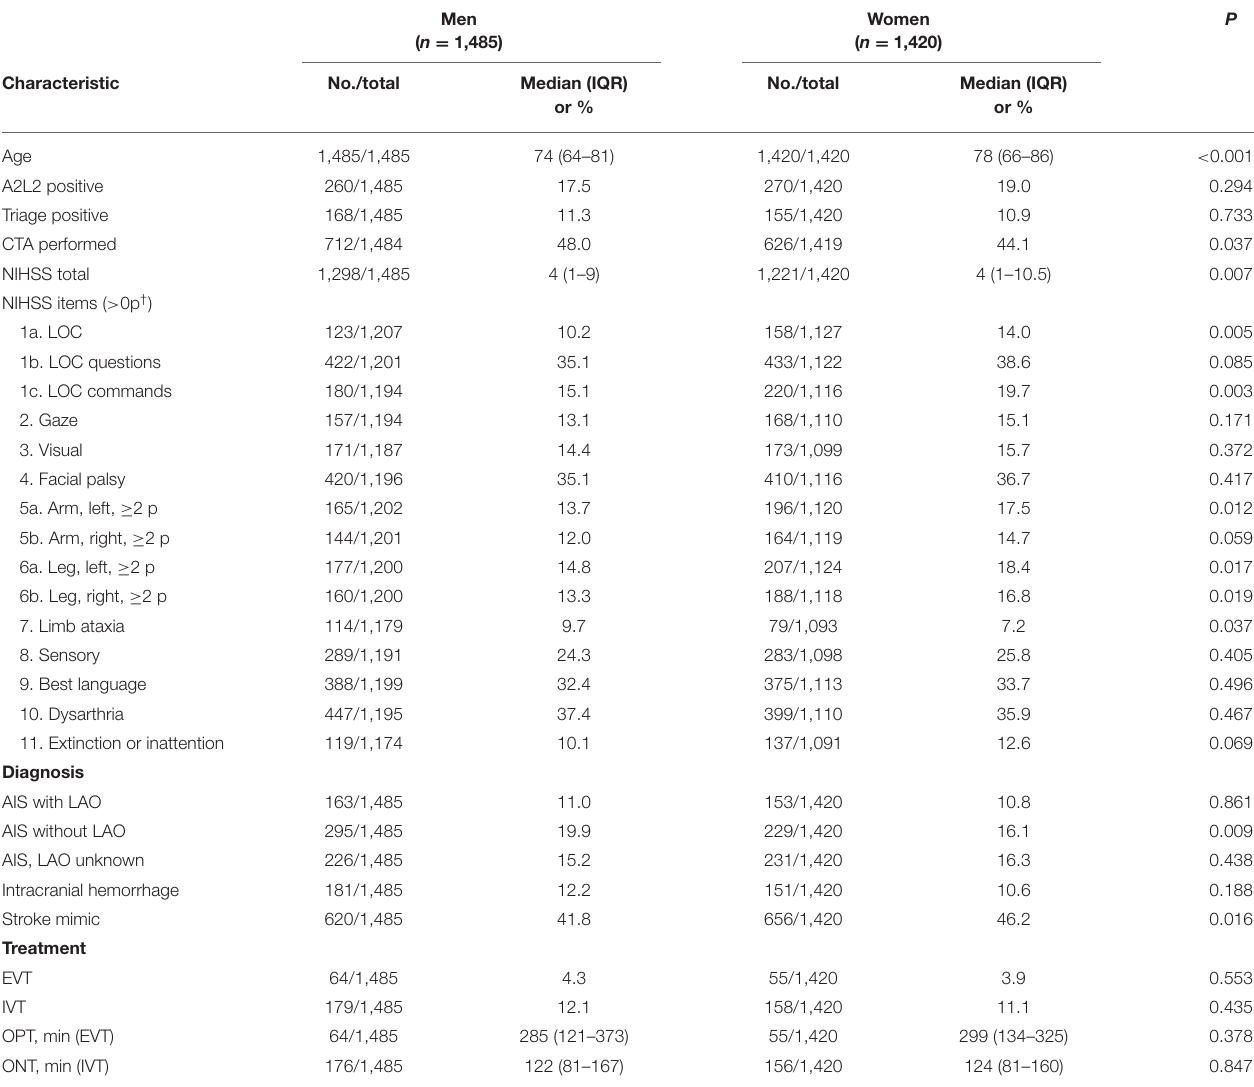
TABLE 1 | Clinical characteristics in men and women.